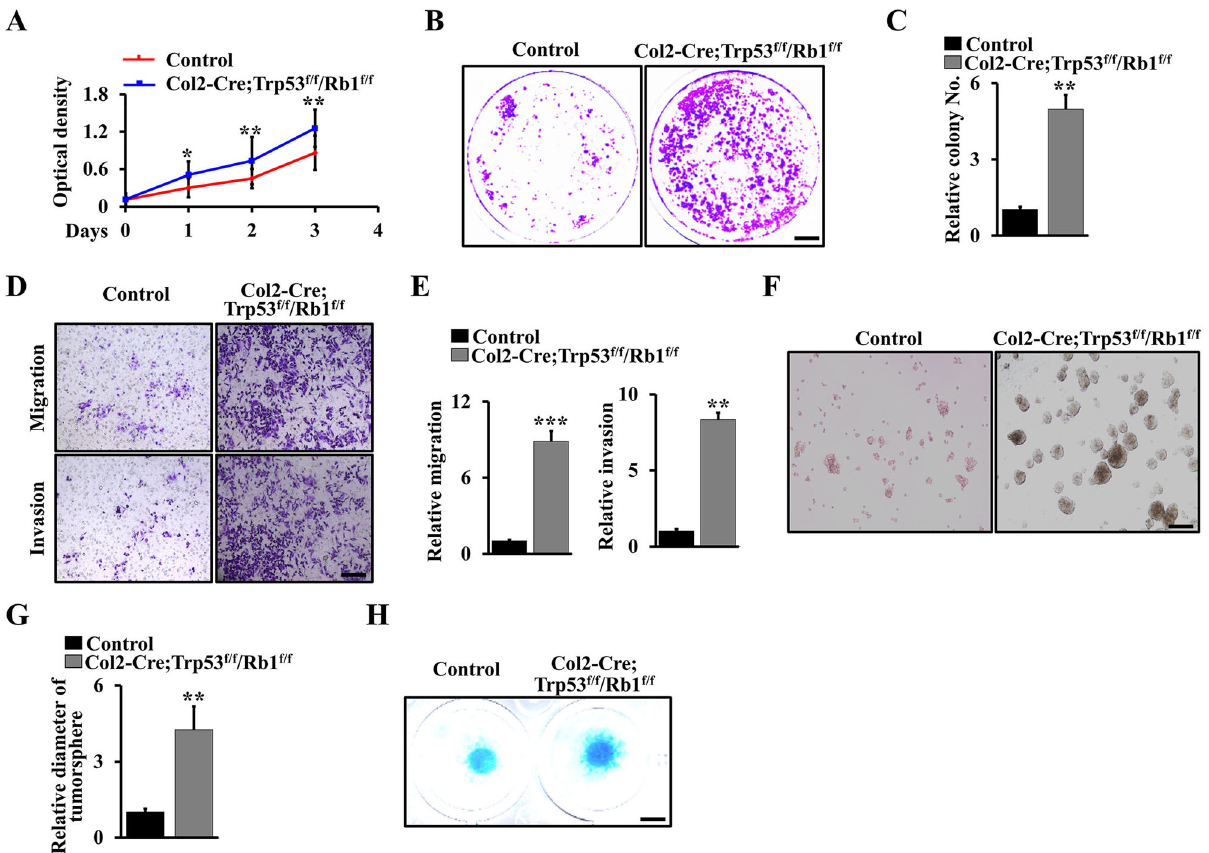
Fig. 3 Deletion of Trp53 and Rb1 increases the expansion and differentiation ability of chondrocytes. A Cell proliferation rate of primary chondrocytes and chondrosarcoma cells from Col2-Cre;Trp53 f/f /Rb1 f/f mice and age-matched controls (Col2-Cre) as shown by WST-1 assay. B , C Soft agar after culture of 3 weeks using primary chondrocytes and chondrosarcoma cells from Col2-Cre;Trp53 f/f /Rb1 f/f mice and age- matched controls, respectively ( B ). Cell numbers were quanti fi ed in the corresponding column as indicated ( C ). N = 3. D Migration and invasion as indicated. E Migration and invasion were quanti fi ed in the corresponding column as indicated. N = 3. F , G Tumorspheres were cultured as indicated for 3 days using primary chondrosarcoma cells from Col2-Cre;Trp53 f/f /Rb1 f/f mice and age-matched controls. The diameter of tumorspheres was quanti fi ed in the corresponding column as indicated ( G ). N = 3. H Micromass culture primary chondrosarcoma cells and chondrocytes from Col2-Cre;Trp53 f/f /Rb1 f/f mice and age-matched controls from Col2-Cre; Trp53 f/f /Rb1 f/f mice and controls. After a culture of 10 days, the macromass cultures as indicated were stained by Alcian blue staining. N = 3. Error bars were the means ± SEM from three independent experiments. * P < 0.05, ** P < 0.01 *** P < soft agar (Fig. 5E, F) and the formation and size of tumorspheres, respectively (Fig. 5G, H). Mechanistically, we found that metformin inhibited the nuclear localization and transcriptional activity of YAP (Fig. 5I, J), and signi fi cantly reduced YAP target genes ’ expression (Fig. 5K). Collectively, our fi ndings suggested that metformin inhibits chondrosarcoma progression through YAP signaling.